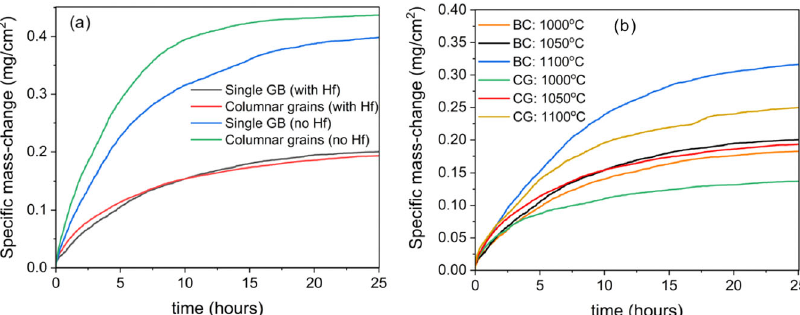
Fig. 7 Oxidation kinetics of NiAl-Hf with different microstructures at variable oxidizing conditions. a Oxidation kinetics with Hf additions and b comparison of Hf doped β -NiAl at different temperatures (BC indicates bicrystals separated by a single-grain boundary and CG indicates columnar